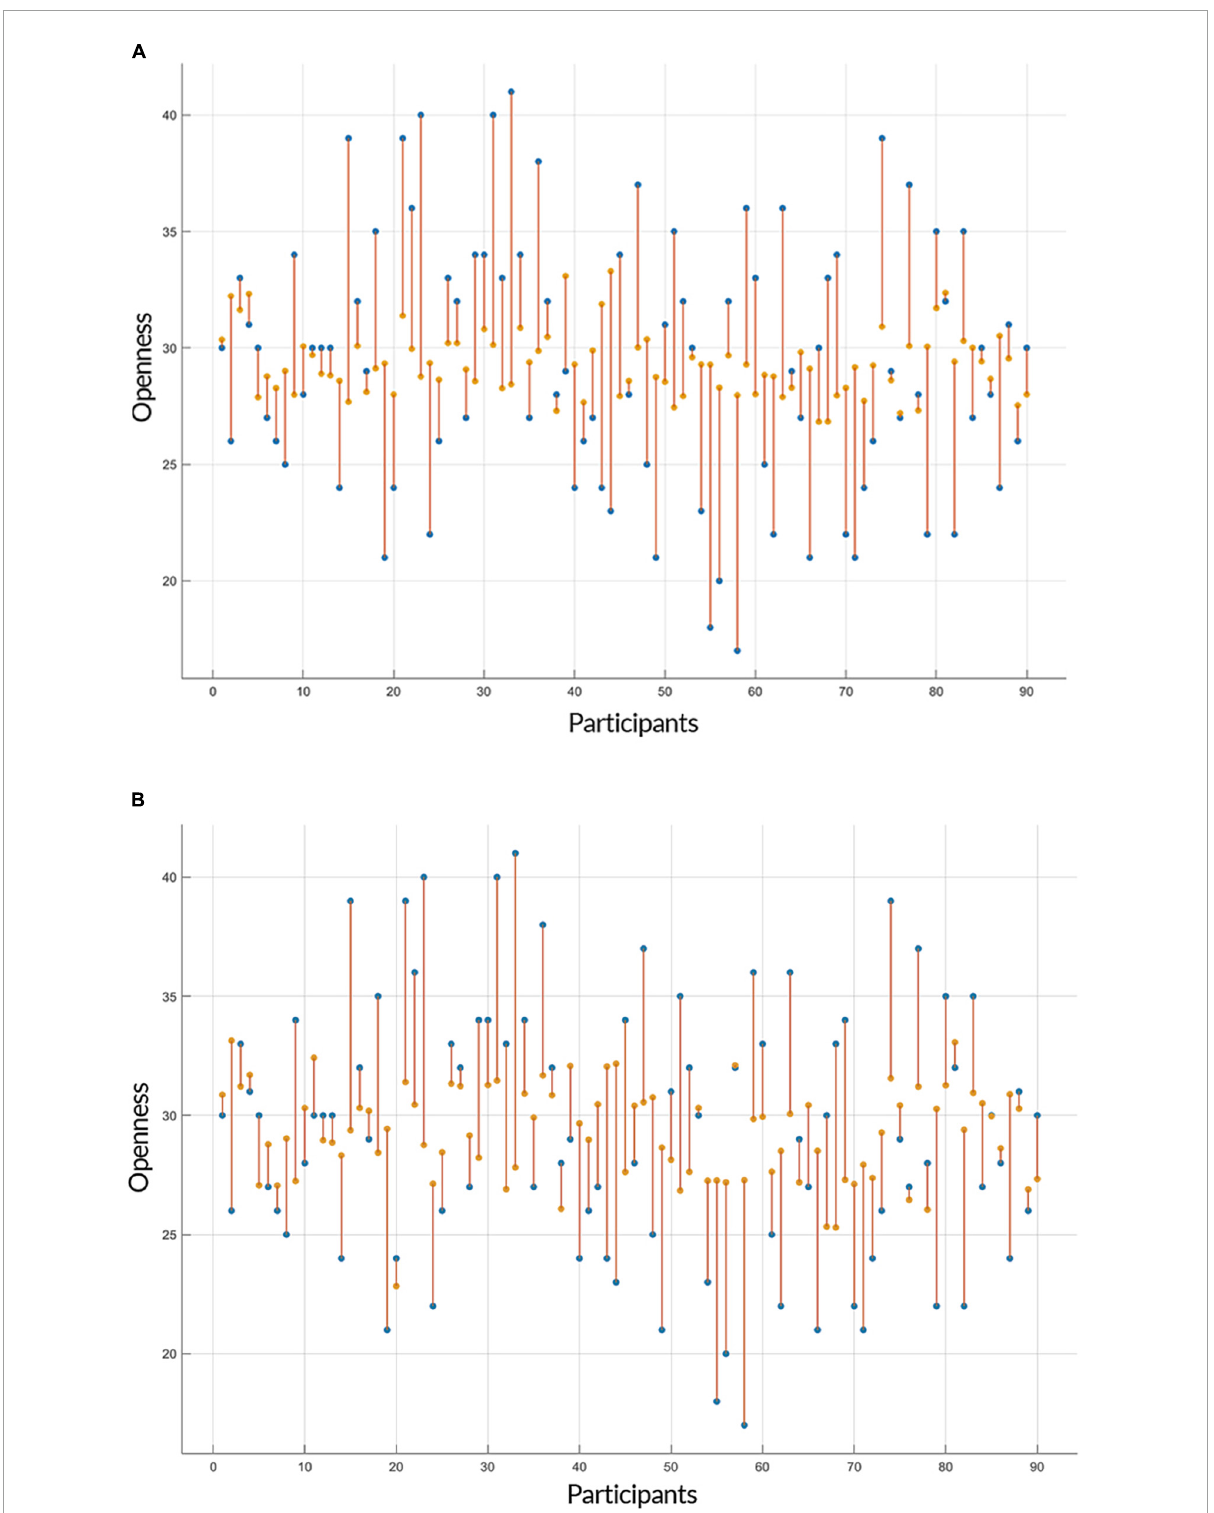
FIGURE3 Prediction of openness to experience based on global efficiency (GE) scores. The plots show the result of the prediction of openness to experience scores (y-axis) of each subject (x-axis) by (A) Gaussian Process Regression (GPR) and (B) linear regression based on the openness to experience and GE scores as inputs. The predicted values are shown in orange and the actual data points are in blue. The orange lines depict the difference between predicted values and the actual